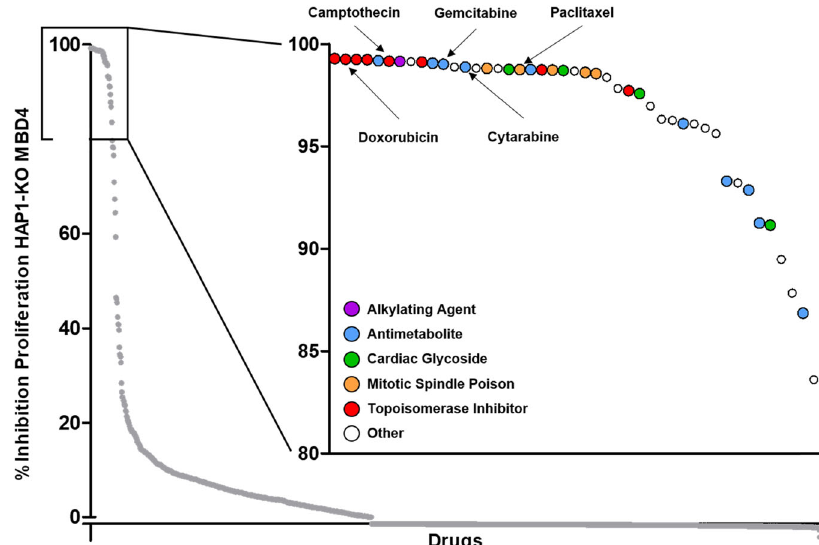
Fig. 1 Screening of the Prestwick Chemical Library corresponding to a collection of 1520 drugs on cell proliferation in the HAP1-KO MBD4 cell line. Scatter plot of the percentage of inhibition of proliferation of HAP1-KO MBD4 cell line treated with a focus on compounds that reduce the proliferation of HAP1-KO MBD4 at over 80%. DMSO was used for the negative